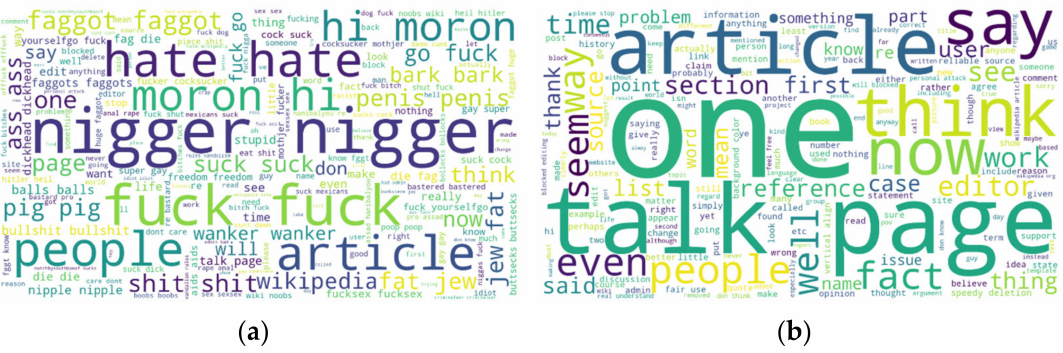
Figure 7. Word clouds of Wikipedia Web Toxicity dataset: ( a ) Toxic and ( b ) Non-Toxic.